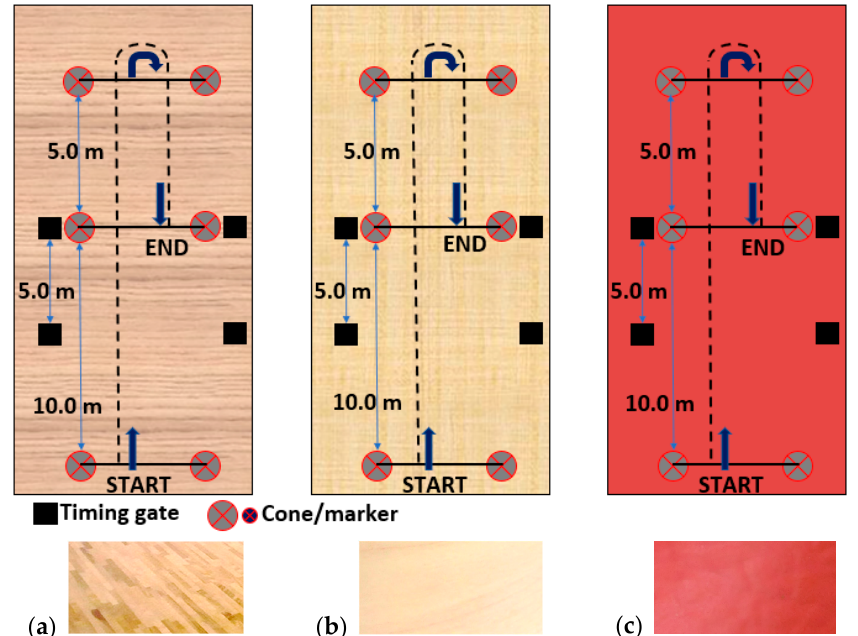
Figure 1. The 505-agility test set-up with different playing surfaces; ( a ) AE: Hardwood surface